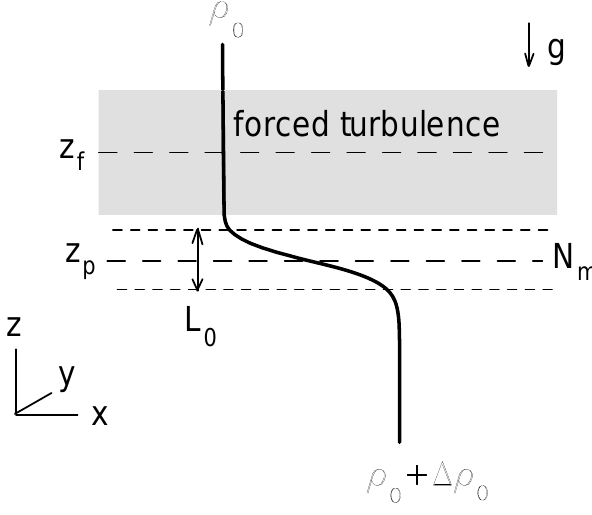
ρ is the density 0